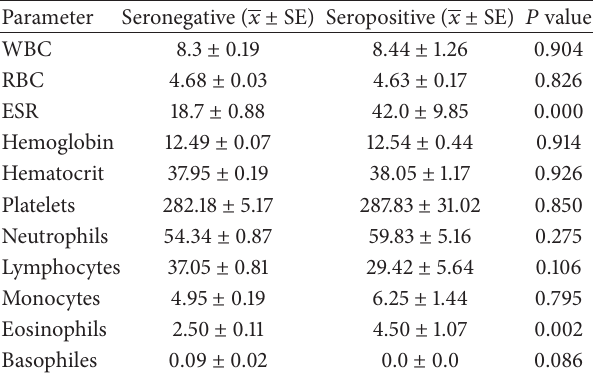
Table 1: Parameters in Toxocara positive and negative